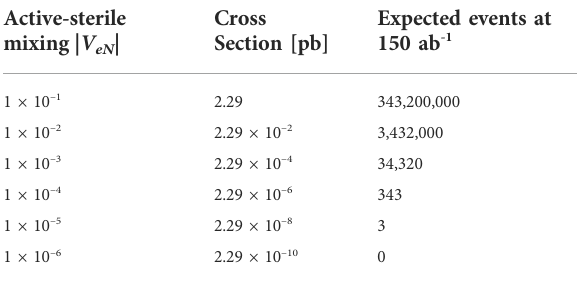
TABLE1Thecrosssectionandexpectednumberofeventsat150 ab − 1 , for an HNL with a mass of 50 GeV and for several choices of | V eN |. Active-sterile Cross mixing | V eN | Section